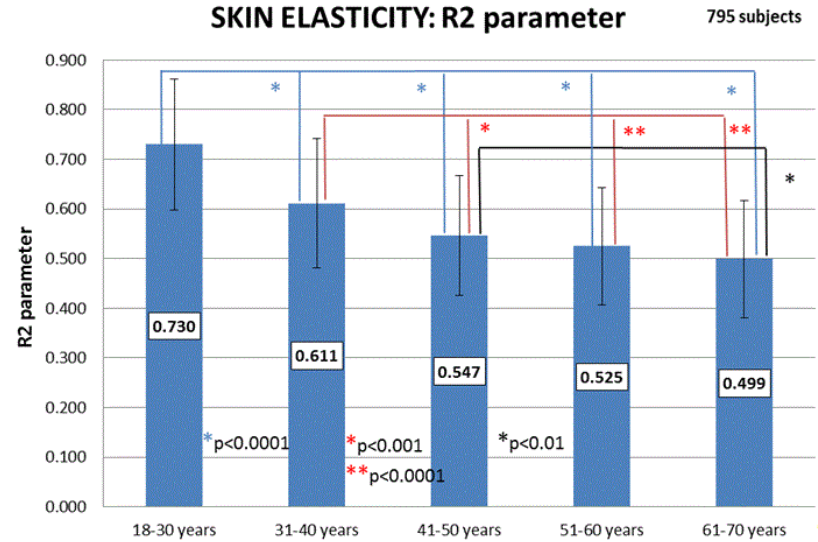
Figure 3. Skin elasticity basal values (R2 parameter) as a function of the age group. Statistical comparison among the age groups: * p < 0.0001 (18–30 vs. 31–40 years;